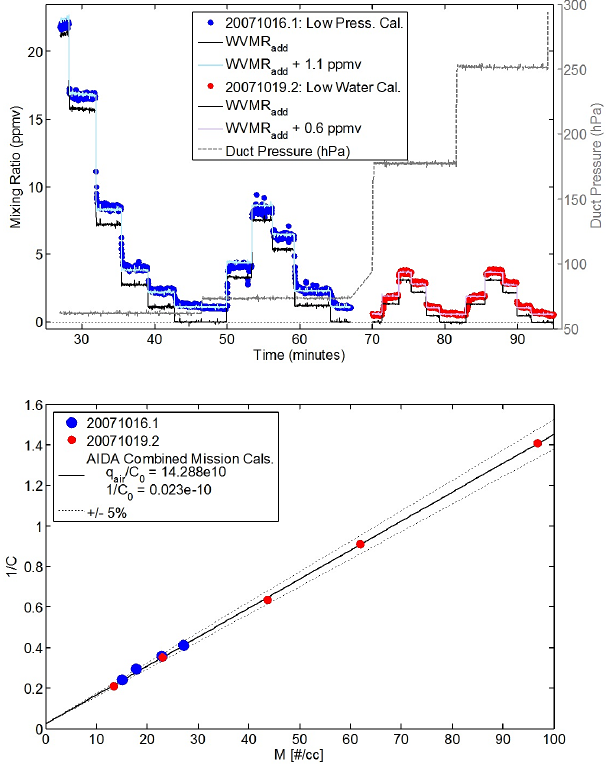
Figure A7. Linearity of the Lyman- α detection method over a range of pressures and mixing ratios representative of chamber conditions on 16 and 19 October. The top panel shows selected dilutions from calibrations executed at low pressures, ∼ 60 to 120hPa (blue), and at low water vapor mixing ratios, 0 to 5ppmv (red). The fluores- cence data, evaluated using calibration constants from a composite of four calibration runs, are plotted as the colored dots; added water vapor, WVMR add , utilizing the bubbler reference standard, is plot- ted as the black line; and the colored lines show the bubbler plus a constant offset representative of the background mixing ratio in the carrier flow for each run. The bottom panel shows the calibration figures (i.e., 1 /C flr vs. M ) with the data from both calibration runs. The solid black line represents the best fit to the full set of calibra- tions performed at the AIDA facility, and the dashed lines show the ± 5% uncertainty range.